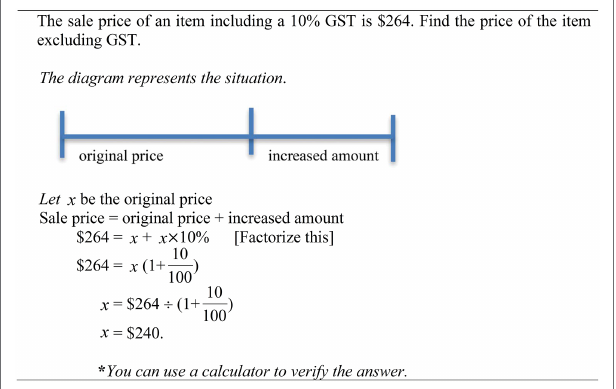
FIGURE 5 | A worked example of a challenging percentage-change problem. Source: Ngu et al. (2018).